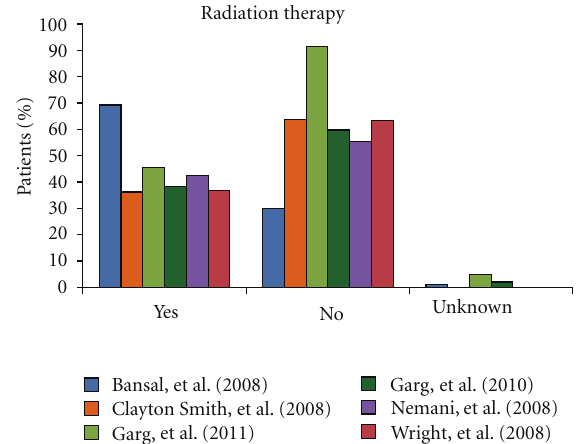
Figure 4: This column-graph shows the percentage of patients that underwent radiation therapy in each of the six chosen index large case-based series of Bansal et al. [8], Clayton Smith etal. [9], Garg et al. [10], Garg et al. [11], Nemani et al. [12], and Wright et al. [13]. Though in five of the six studies more patients did not have radiation therapy as part of their treatment regime, the di ff erence is not significant. This is probably best explained by the remaining unanswered controversy that questions the improvement in survival rates associated with this modality of adjuvant